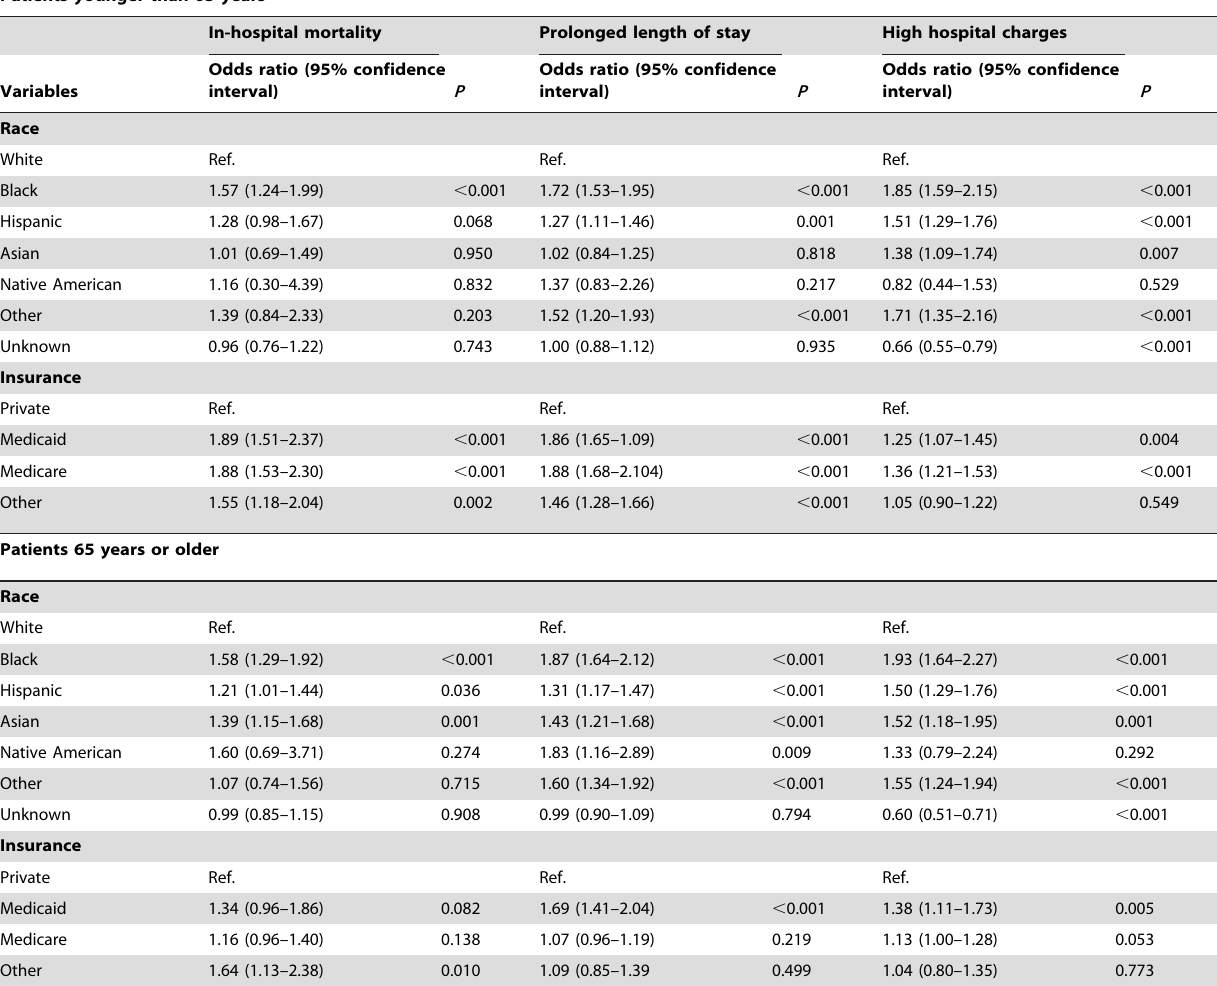
Table 4. Multivariable logistic regression analyses with general estimation equation adjustment assessing in-hospital mortality, prolonged length of stay and high hospital charges stratified according to age ( , 65 years and $ 65 years), Nationwide Inpatient Sample,